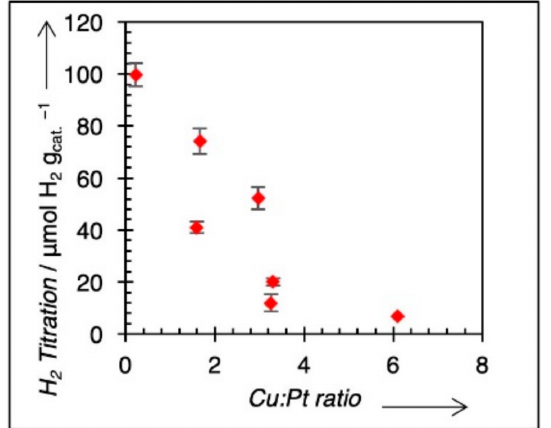
Figure 4. H 2 titration results for O-pre-covered catalysts. Values decline as Pt is diluted by Cu on the Pt–Cu surface.